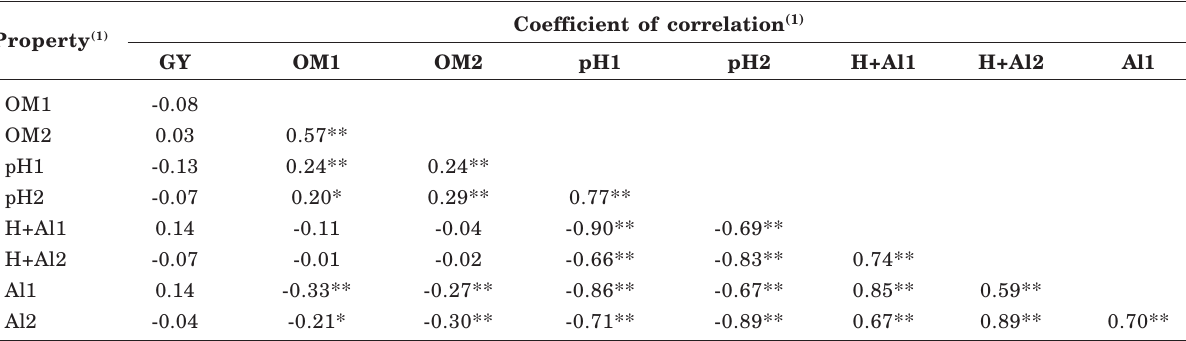
Table 4. Matrix of simple linear correlation between rice grain yield and some chemical properties of a